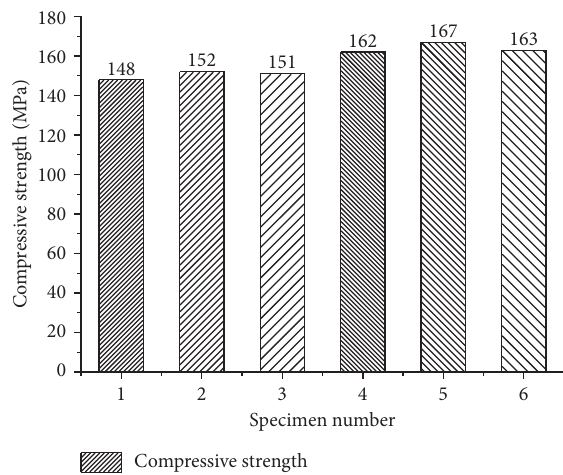
Figure 8: Compressive strength of each group of